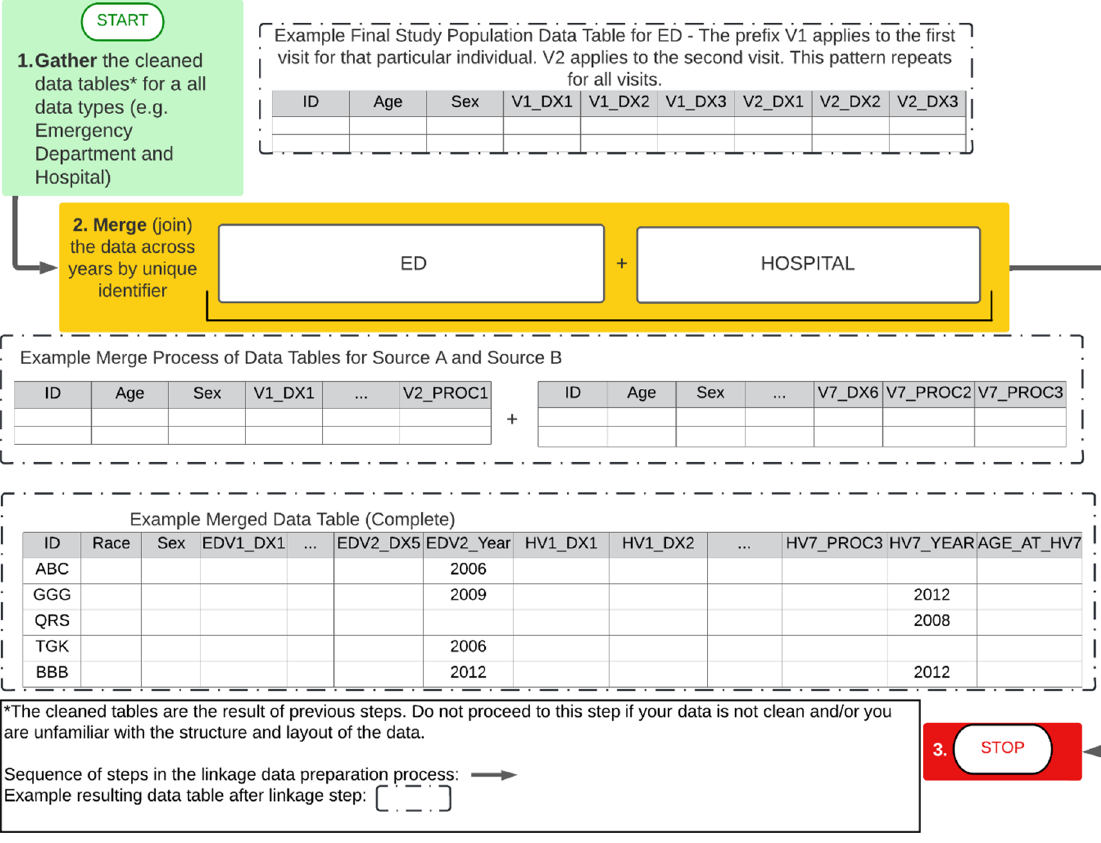
(Figure 7). The latter allows analysis across data sources while the former allows analysis by the source.